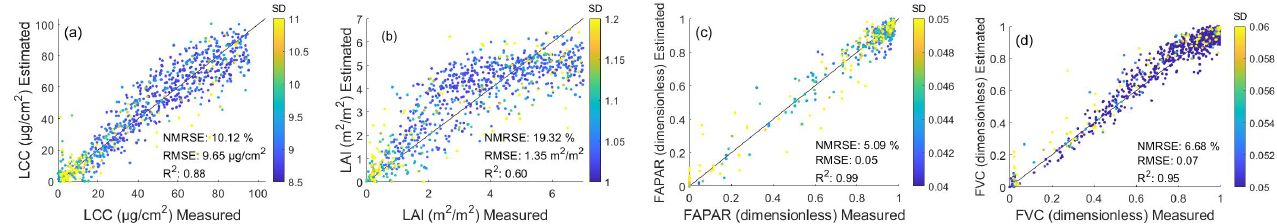
Figure 3. Theoretical validation of trait specific S3-TOA-GPR-1.0 retrieval models: LCC ( a ), LAI ( b ), FAPAR ( c ), and FVC ( d ) using the simulated SCOPE-6SV database (1750